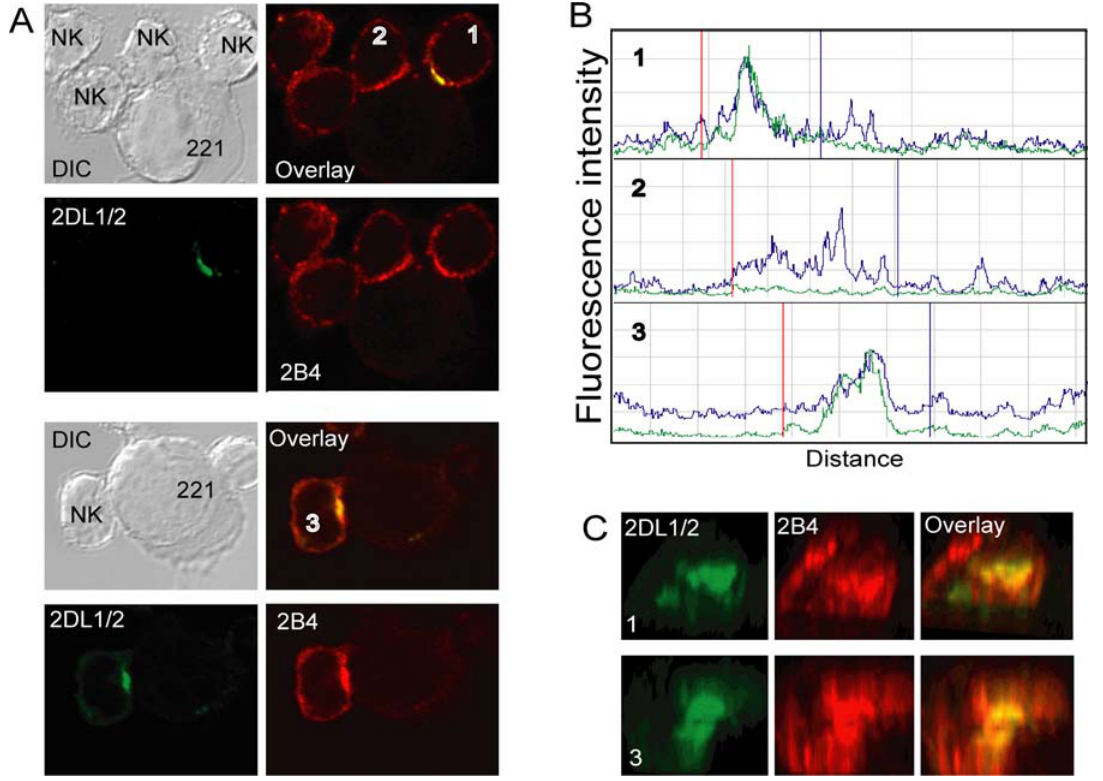
Figure 4. 2B4 accumulates at both activating and inhibitory synapses. Activated NK cells were mixed with target cells at 37 u C for 10 minutes, fixed, permeabilized, and stained with the cyt42/43 antiserum and a mAb to 2B4 followed by the appropriate secondary antibodies. (A) Mixed with .221-Cw15 target cells. Confocal microscope z -series were obtained, and single sections are shown. The cells labeled # 1 and # 3, which display KIR expression and clustering, represent inhibitory synapses while cell # 2, which lacks KIR2DL1 expression, is an activating synapse. The NK cells without a number in the top image were not analyzed, because they did not appear to form tight conjugates with target cells. (B) The fluorescence intensity was scanned around the perimeter of conjugated NK cells. Profiles labeled 1, 2, and 3 are from the corresponding cells in Figure 4A. The green and blue lines represent the cyt42/43 and anti–2B4 fluorescence, respectively. Vertical red and blue lines mark the boundaries of cell contact as determined in DIC images. (C) Confocal z -stacks were used to create an en face view of the zone of cell contact in 2 inhibitory synapses.